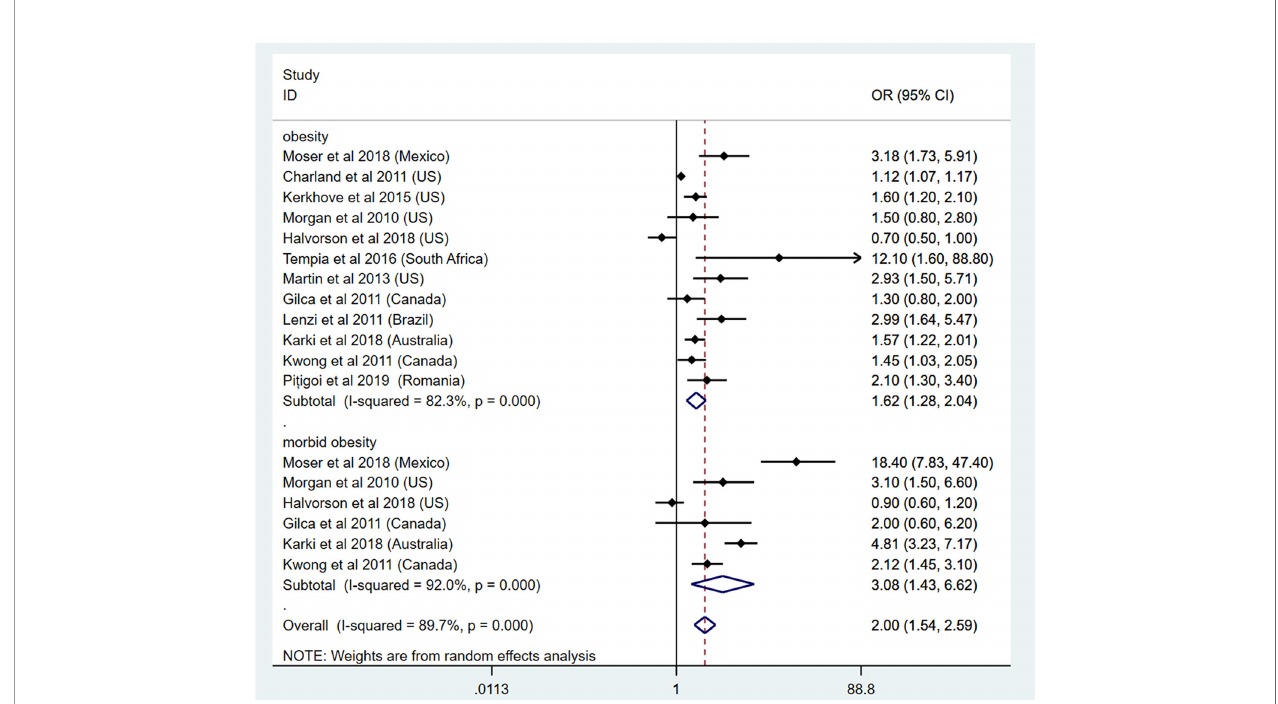
FIGURE 3 | Odds ratios for in fl uenza-induced hospitalization in patients with obesity and morbid obesity.